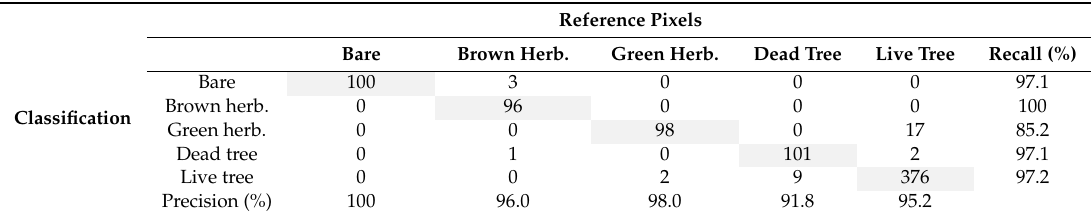
Table 4. WorldView-2 classification (1 September 2018 image) confusion matrix. Overall accuracy = 96%.